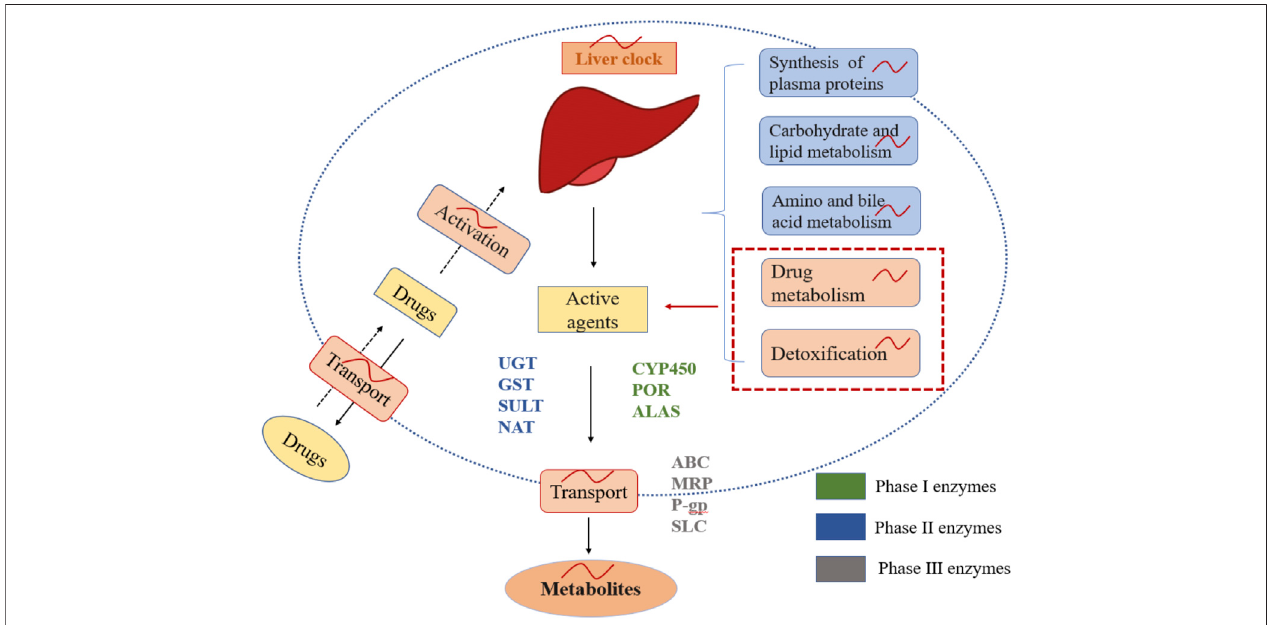
FIGURE 3 | Chrono-pharmacokinetics of drug metabolism, detoxi fi cation, and delivery with metabolizing enzymes in the liver. The liver is controlled by circadian clocks that account for chrono-pharmacokinetics. Drug metabolism, detoxi fi cation, and delivery with metabolizing enzyme families are rhythmic in the liver.